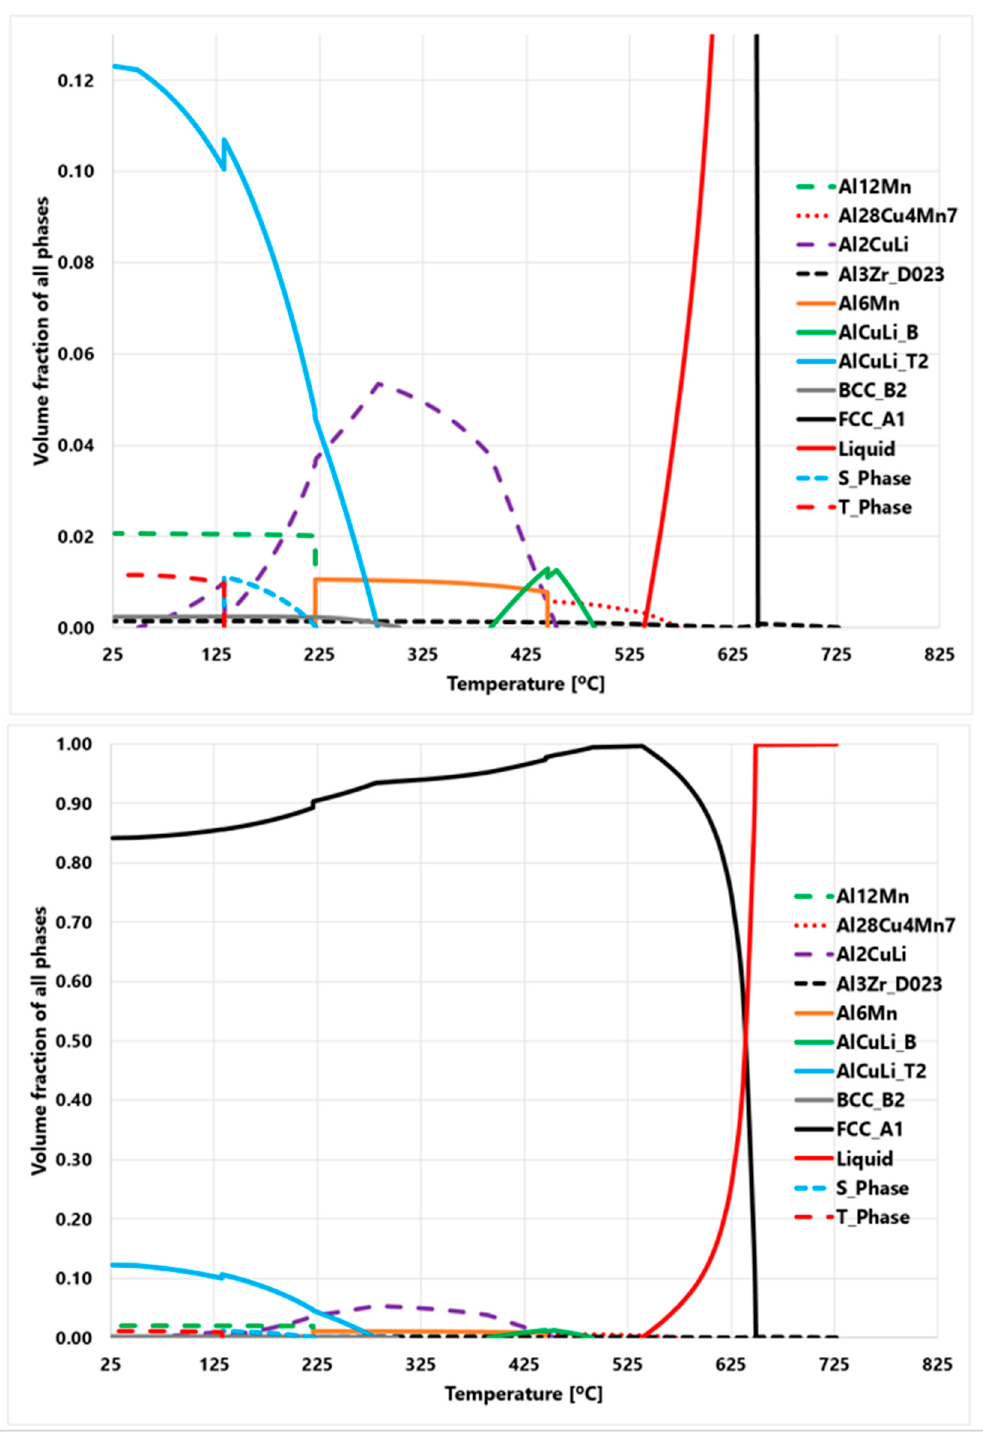
Figure 7. Thermo-Calc prediction results of the Al2050 alloy demonstrating the amounts of phases as a function of temperature.